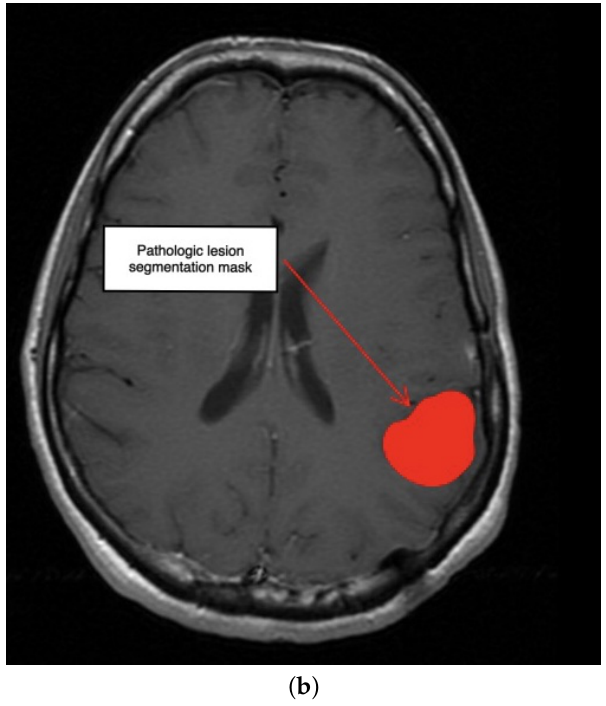
Figure 7. Experimental assessment, second patient. Segmentation with slicer 3D ( a ) coronal, sagittal, transversal, and 3D visualization, ( b ) only axial visualization, the light green color identifies the segmented area.